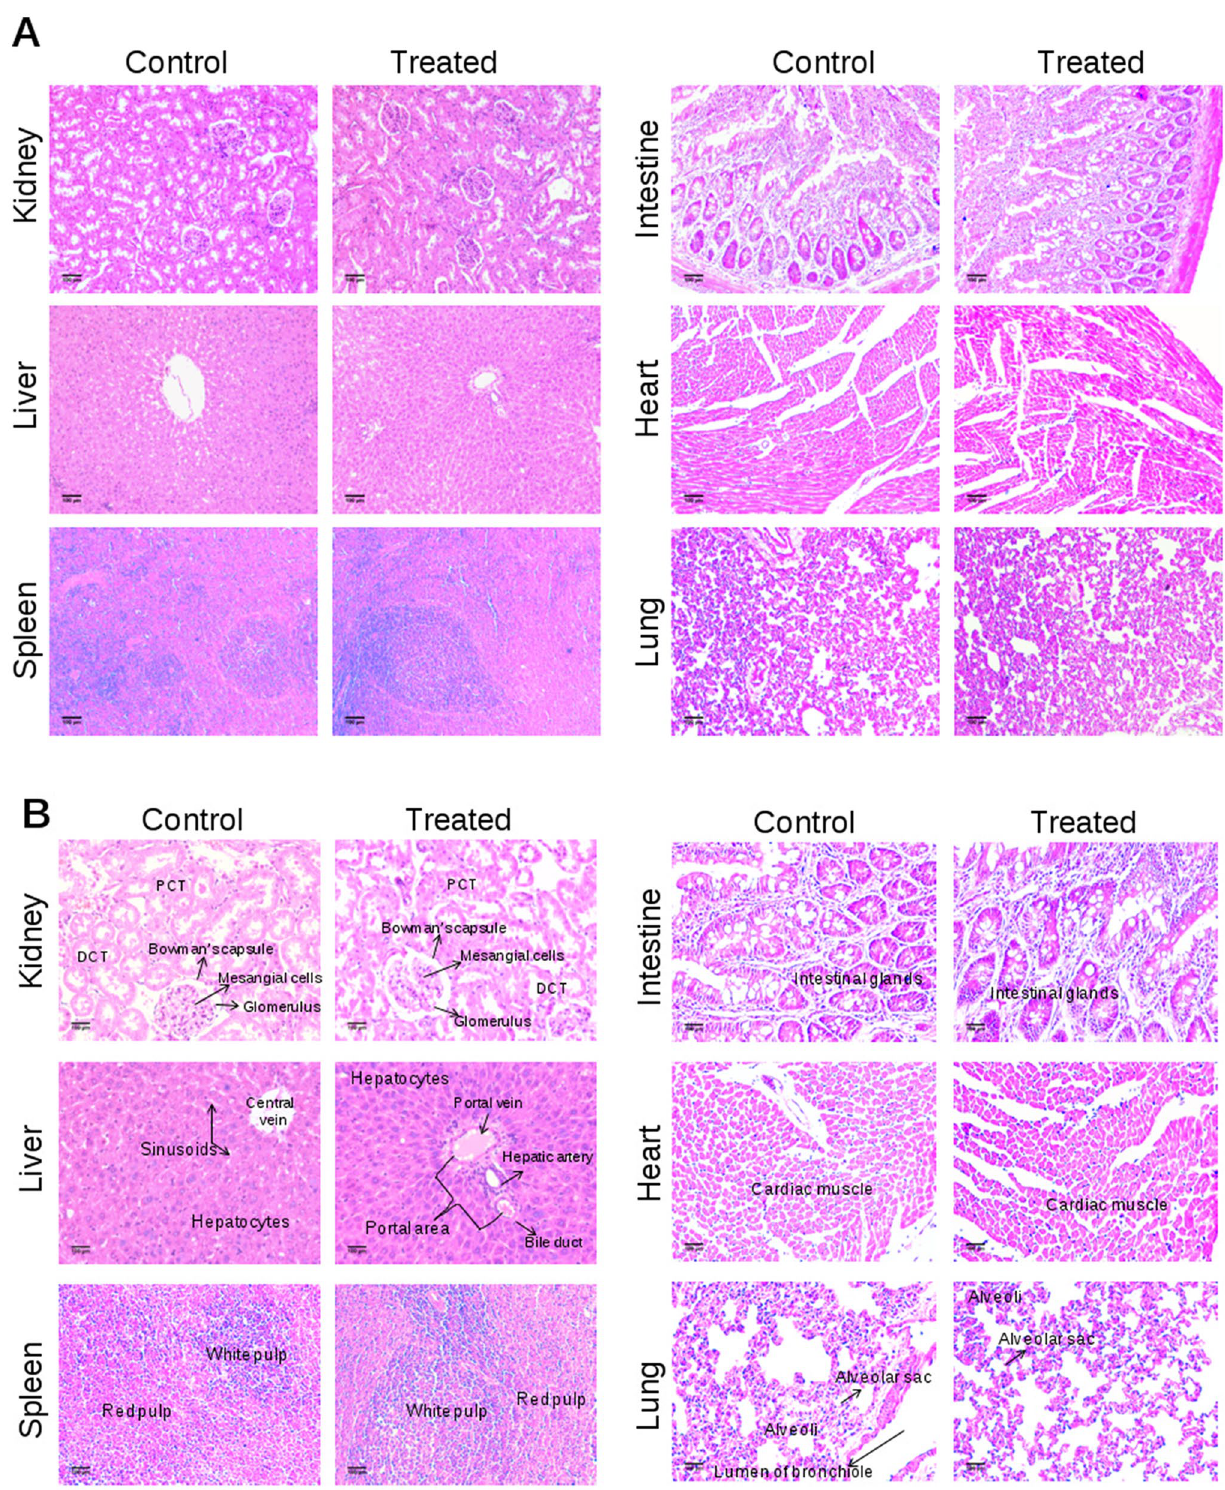
Figure 7. Histopathological analyses of different tissues of rat following administration of Disarib. ( A , B ) HE staining of tissues from control and 2000 mg/kg Disarib treated rats. Images shown are with a magnification of 10 × ( A ) or 20 × ( B ). DCT distal convoluted tubule, PCT proximal convoluted tubule. Scale bar 100